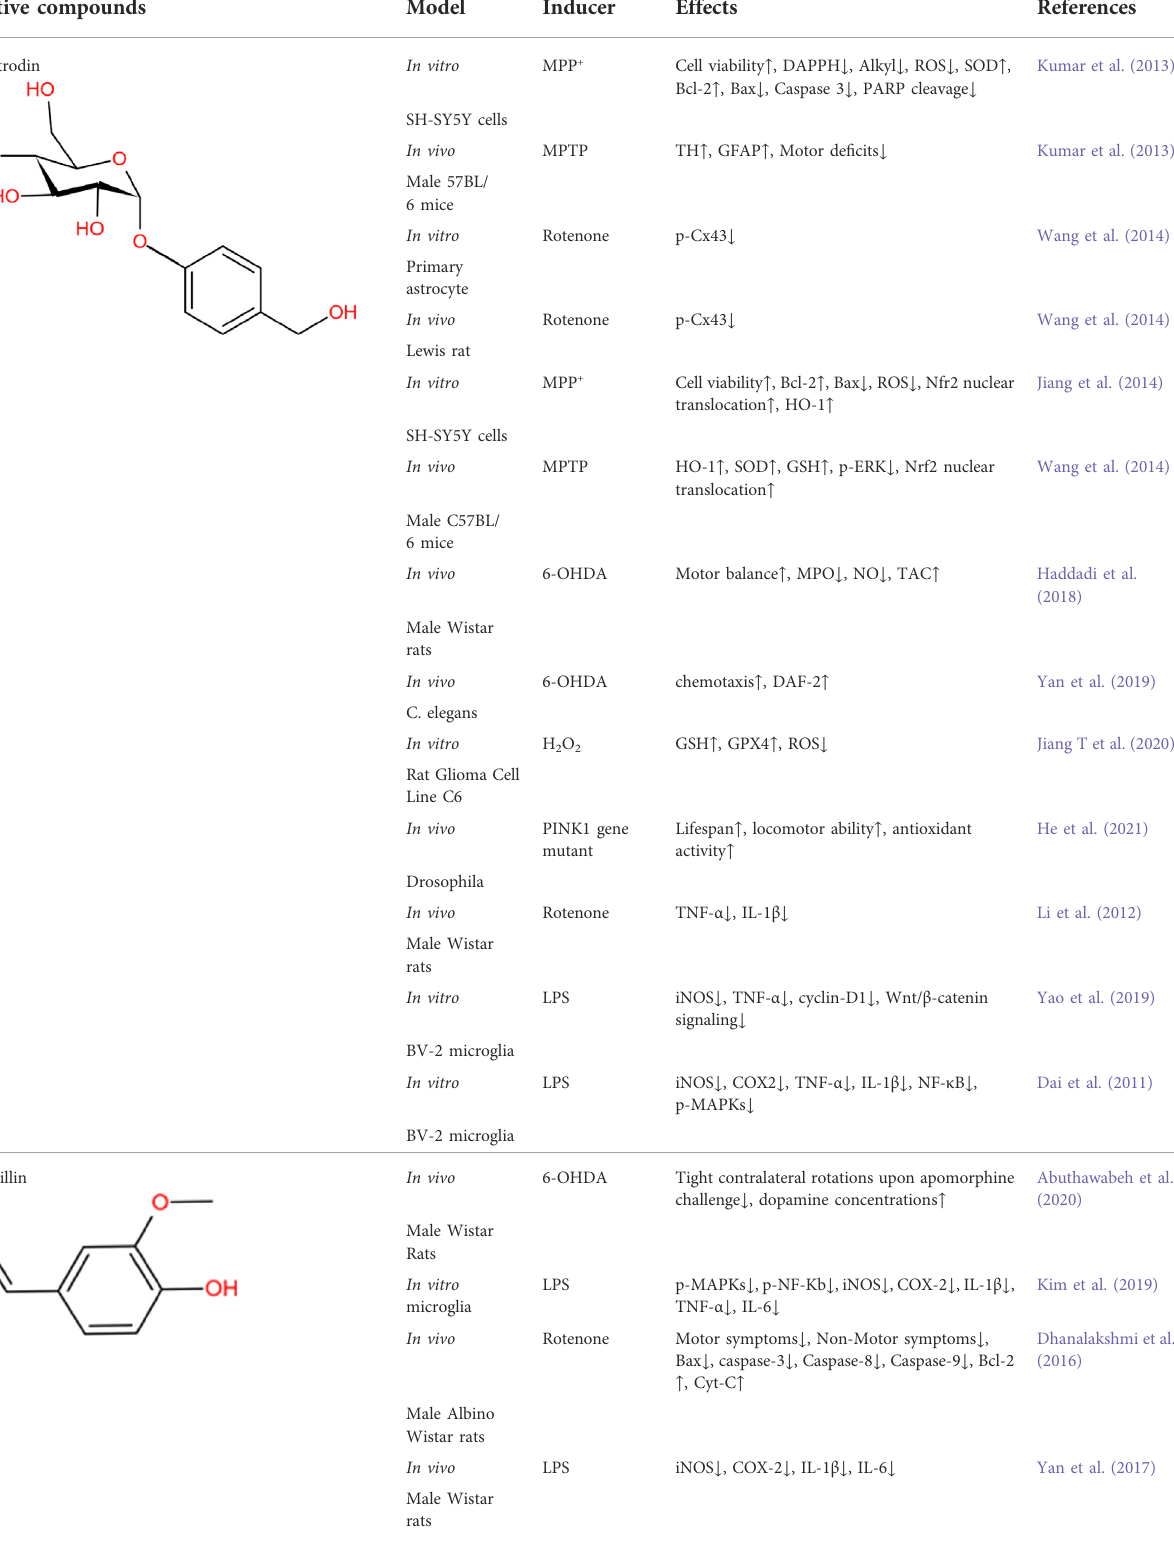
TABLE 1 The effects of bioactive Tianma compounds on various in intro and in vivo PD